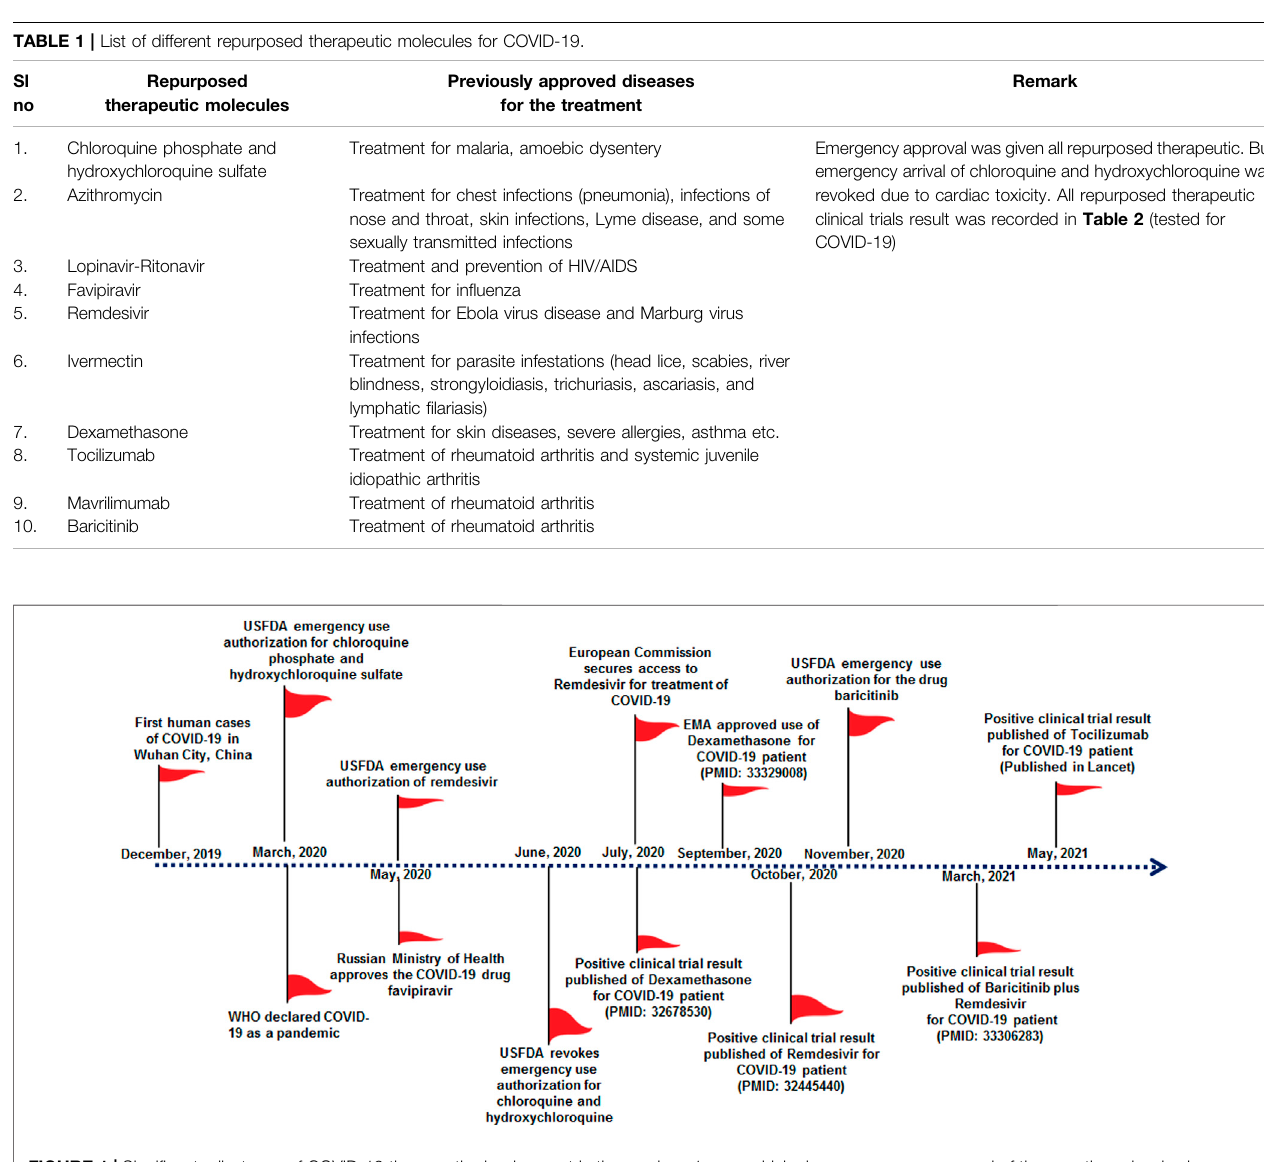
Frontiers in Pharmacology |